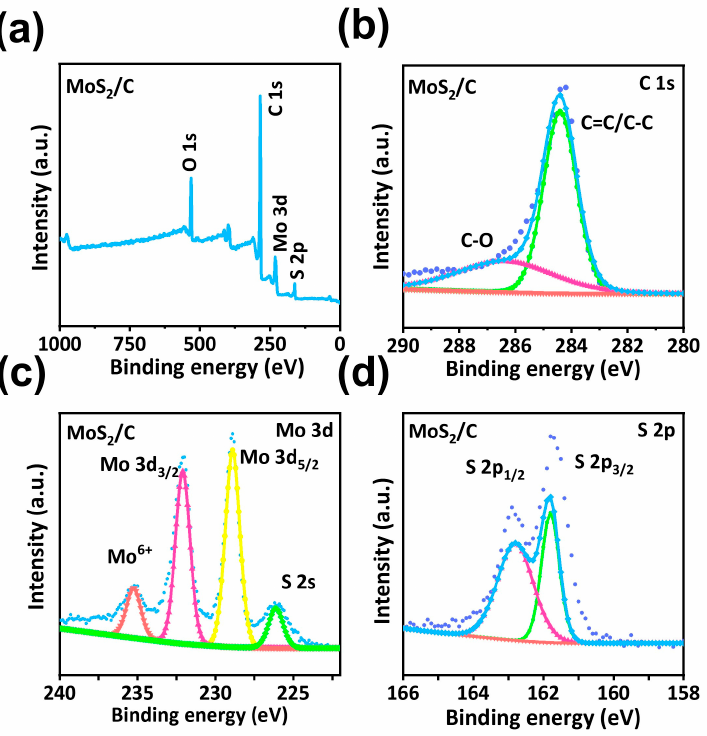
Figure 3. Structural characterization. ( a ) XPS survey scan of hollow MoS 2 /C nanoflowers. High-resolution ( b ) C 1s, ( c ) Mo 3d and ( d ) S 2p spectra of MoS 2 /C, respectively.